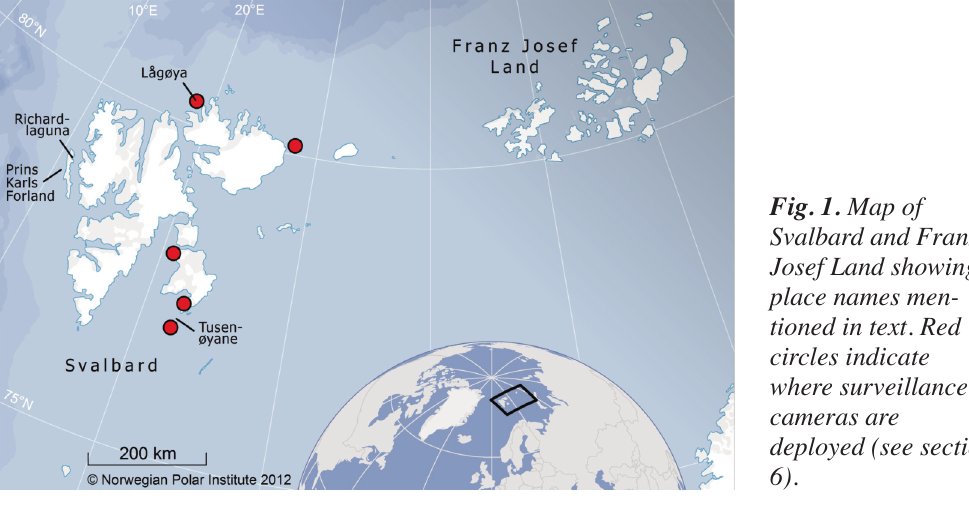
Walrus of the North Atlantic 176